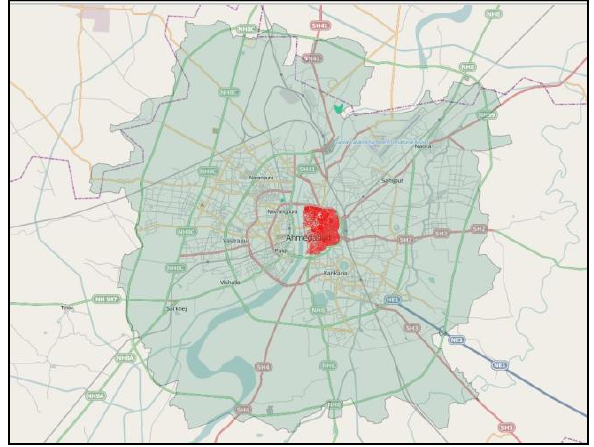
Figure 1. The historic core within the Ahmedabad Municipal